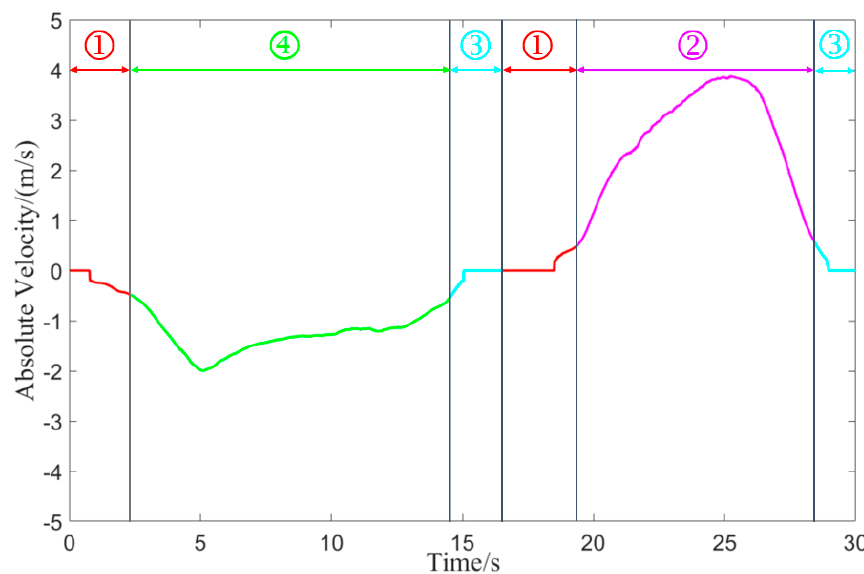
Figure 10. Target-vehicle absolute velocity time history curve.